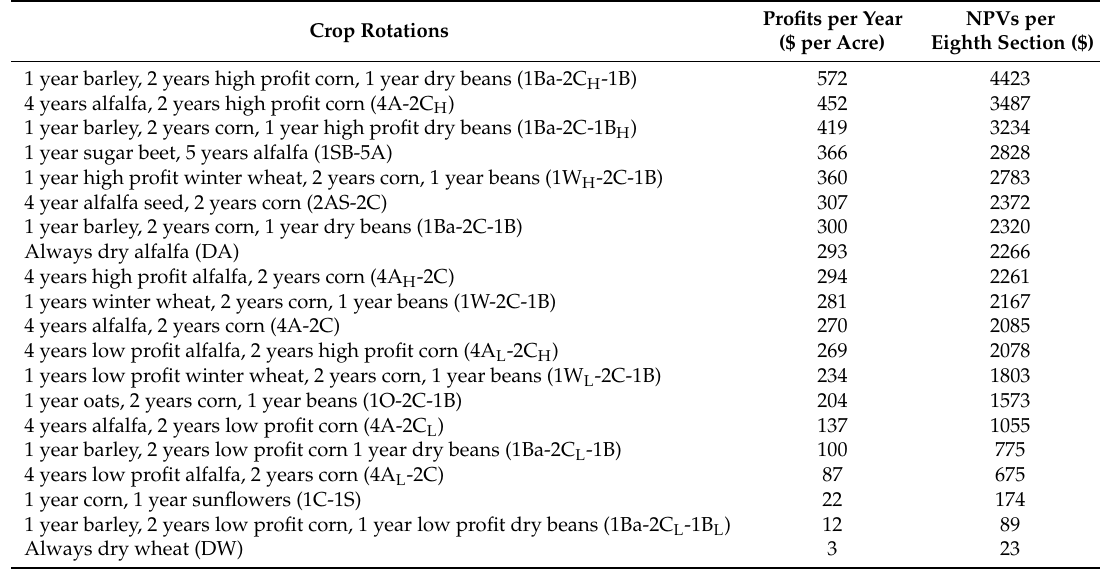
Table 3. Net present values (NPVs) of the crop rotations for ten years. Crop